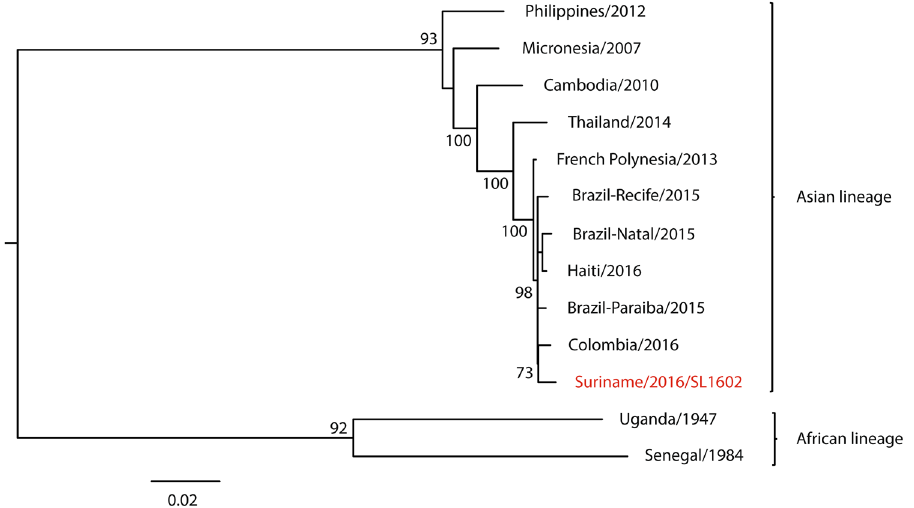
Figure 2. Phylogenetic tree for ZIKV SL1602 and 12 selected ZIKV isolates that represent the recognized diversity. A maximum likelihood phylogenetic tree inferred from the nucleotide sequences of full-length ZIKV genomes is shown. The country of isolation and GenBank accession numbers of the isolates that were used are: Uganda MR 766 (NC012532), Brazil-Natal (KU527068), Thailand (KU681081), Philippines (KU681082), Brazil-Paraiba (KX280026), Colombia (KX247646), Brazil-Recife (KX197192), Haiti (KX051563), Senegal (KU955591), Cambodia (KU955593), Federated States of Micronesia (EU545988) and French Polynesia